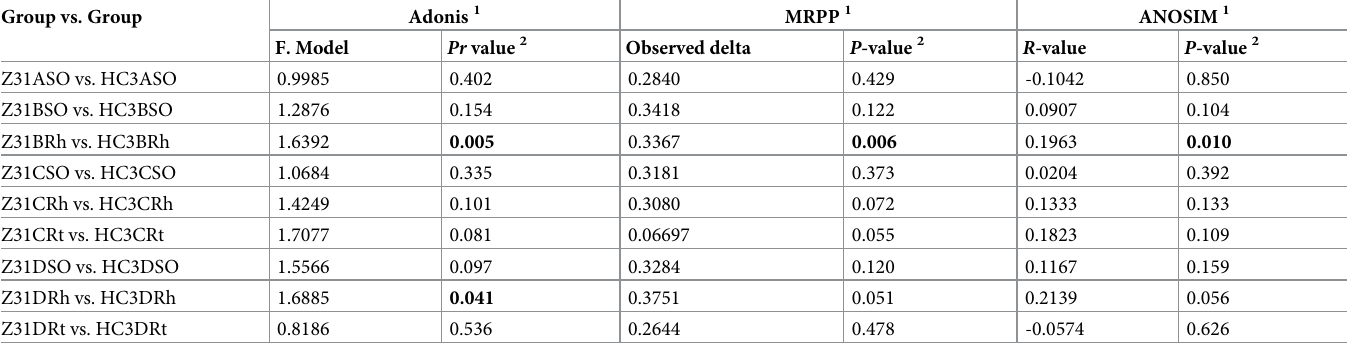
Table 2. Significance tests of bacterial community structure between the transgenic soybean line Z31 and its recipient cultivar HC3 at different stages with three different statistical approaches. Group vs.